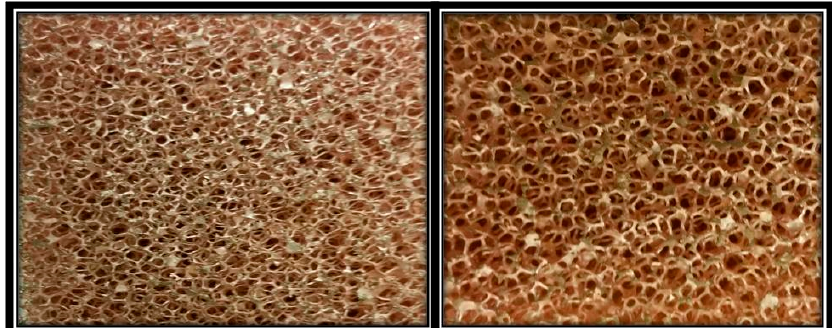
Figure 2. Copper foam inserts utilized in enhancement studies [47] .